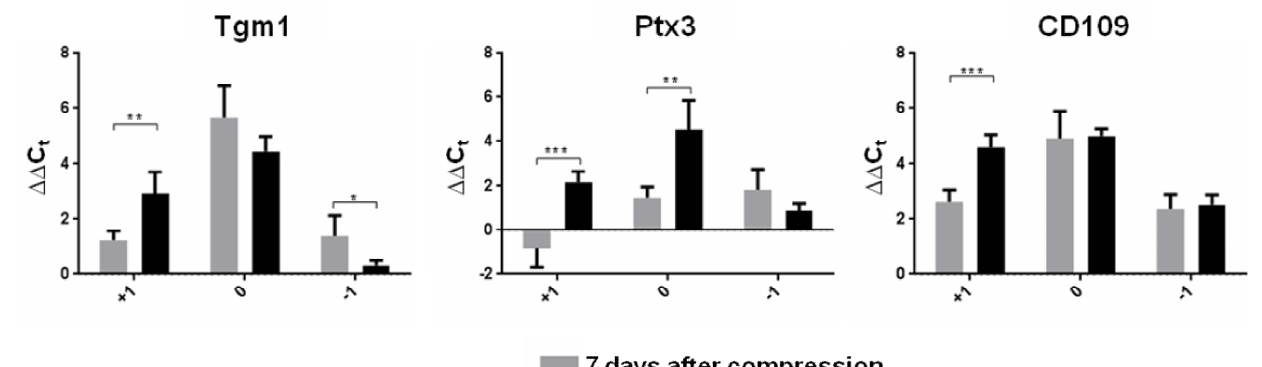
Figure 5. Expression of genes induced by neuroprotective A2 astrocytes one and two weeks after Th9 compression. Data are mean values of five experiments ±SD. The mRNA levels for each marker were normalized to the mRNA levels of 18sRNA and expressed as ∆∆C t values relative to controls. Results were statistically evaluated using unpaired t -test; * p ˂ 0.05; ** p ˂ 0.01; *** p ˂ 0.001. Tgm1—Transglutaminase 1; Ptx3—Pentraxin 3; CD109—Cluster of differentiation 109.